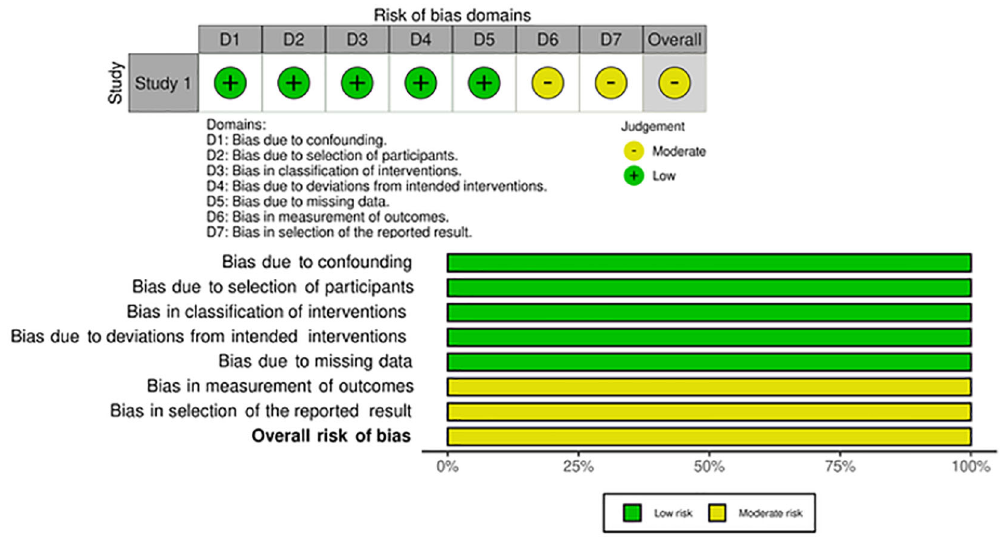
Figure 2. Risk of bias assessment of study two by Hess et al . Theintervention group showedearlierclinical recovery and discharge instudytwo(Hess etal. , 2021).The28-dayoverall survival had no significant difference, while freedom from intubation was 90% vs. 60% (P = 0.16). Lower oxygen requirement at the time of intervention and less time to clinical recovery (P = 0.01) were needed by patients aged 65 or